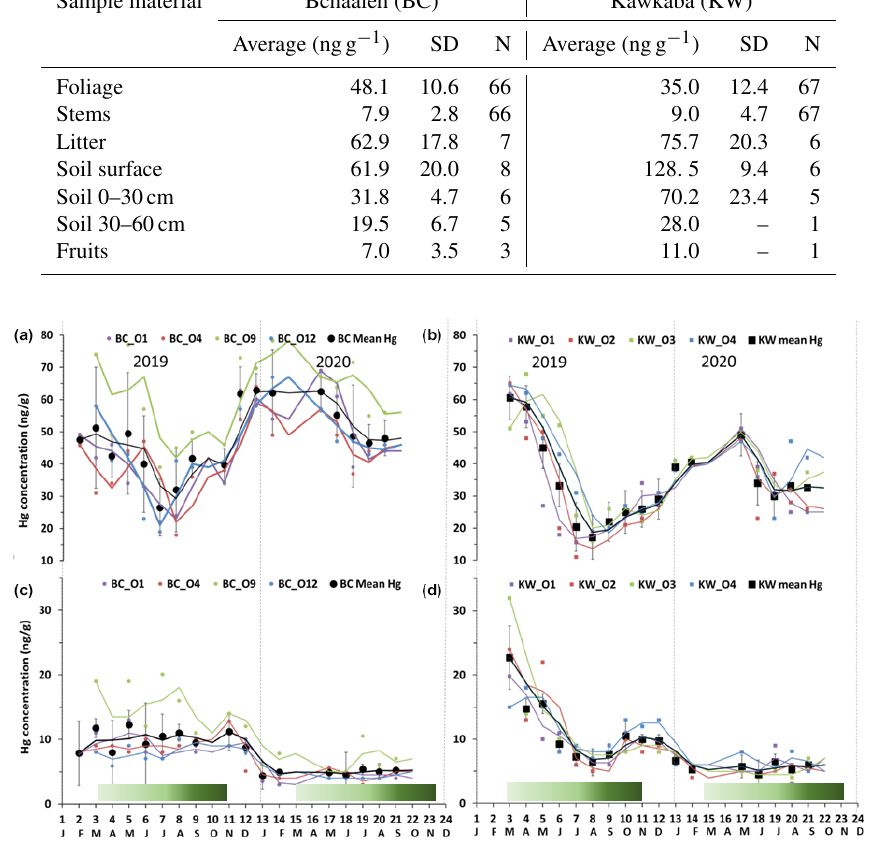
Figure 2. Seasonal variations of foliage Hg concentration in (a) Bchaaleh (BC) and (b) Kawkaba (KW) olive groves, and stems Hg concen- tration in (c) Bchaaleh and (d) Kawkaba olive groves. Shaded green horizontal bars represent the leaf development of olive trees during the growing season of cultivars in Spain according to the BBCH scale (Sanz-Cortès et al., 2002).